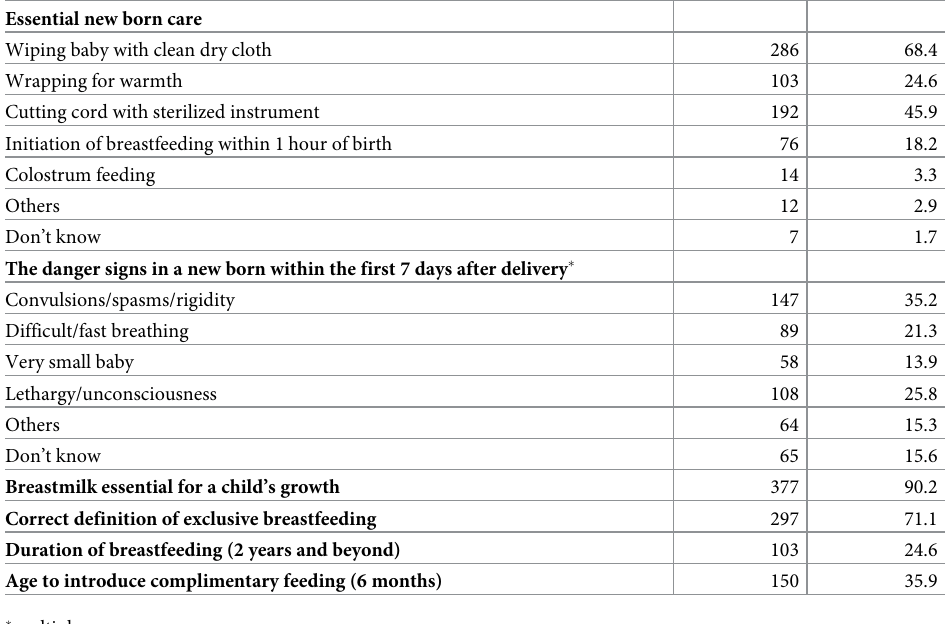
Table 4. Respondents knowledge of newborn health and breast feeding. Essential new born